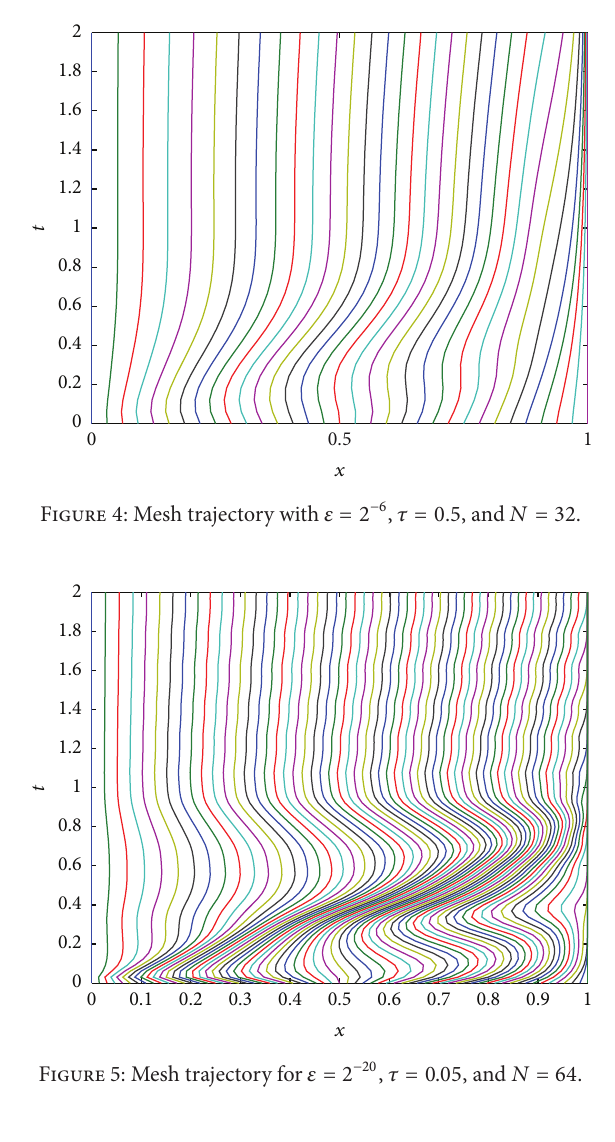
redistributed at the next iteration or time step, but up to date no bounds have been given explicitly. Apart from this drawback, this method fully resolves the boundary layer and is computationally efficient as can clearly be seen from the numerical